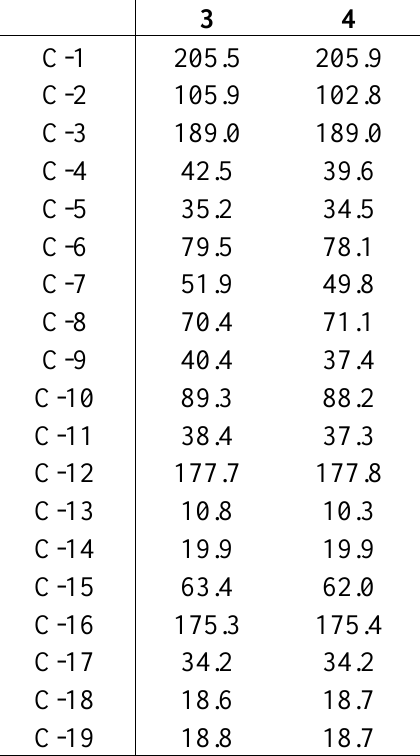
Table 3. 13 C NMR chemical shifts (ppm) of isomers 3 and 4